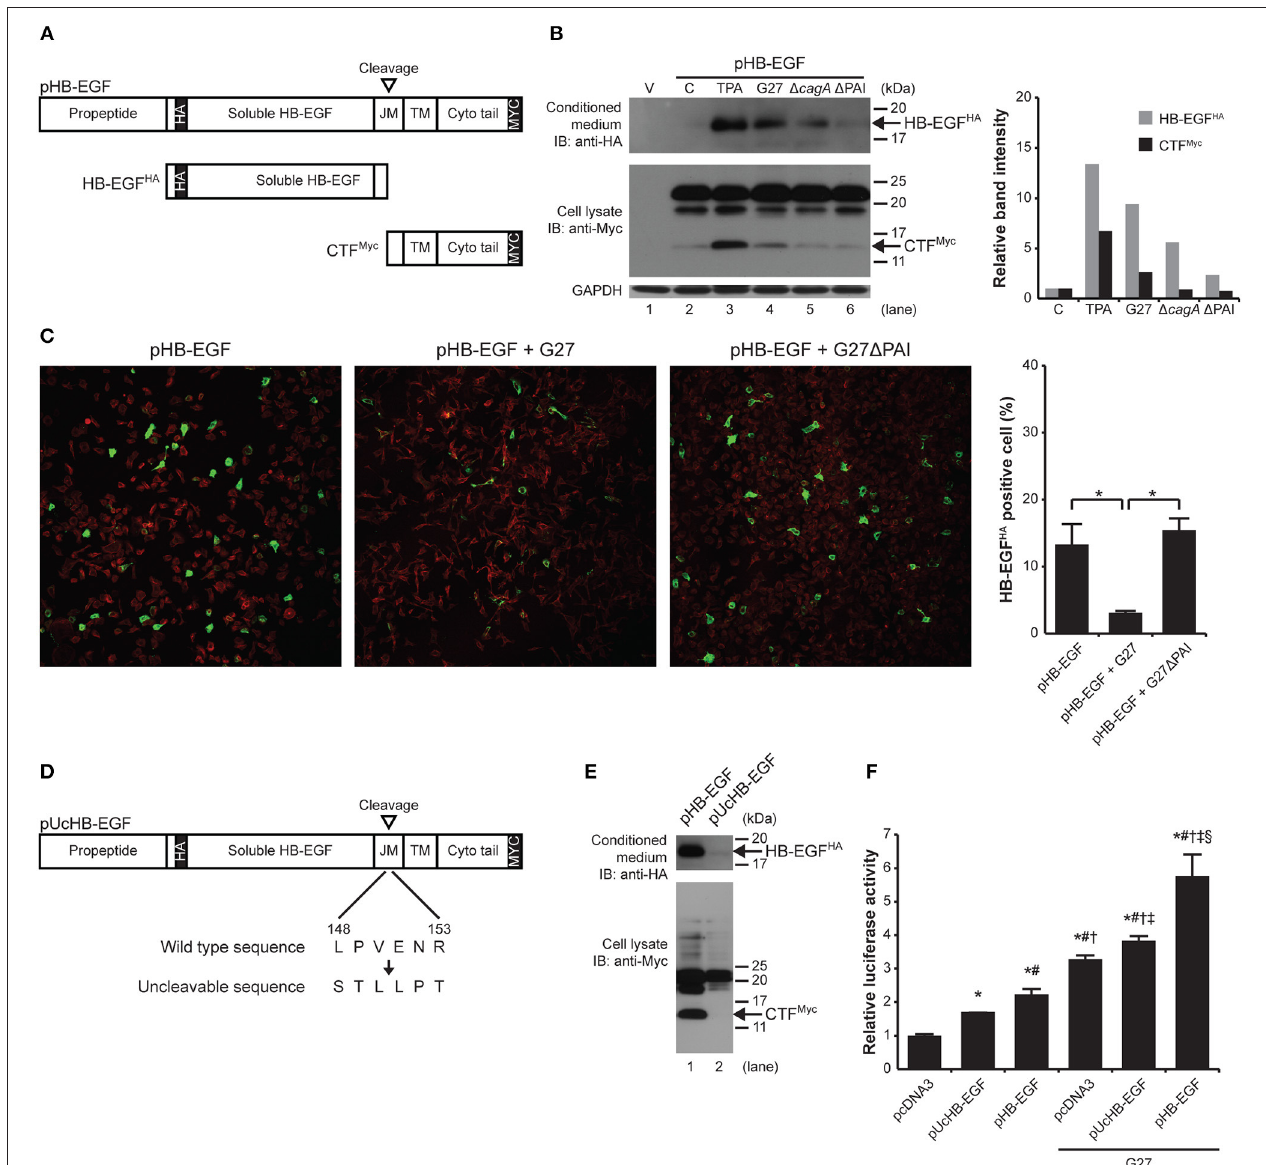
FIGURE 5 | H. pylori -induced HB-EGF shedding is important for gastrin expression. (A,D) Schematic diagrams of double epitope-tagged membrane-anchored proHBEGF-HA/Myc and Uncleavable proHBEGF-HA/Myc constructs, pHB-EGF, and pUcHB-EGF, respectively. (B) AGS cells were transfected with pcDNA3 (lane 1) or with pHB-EGF (lanes 2–6). Cells expressing proHBEGF-HA/Myc were treated with 1 µ M TPA for 30min, or infected with G27 WT, G27 1 cagA , or G27 1 PAI for 4h. Existence of shed HB-EGF HA in concentrated conditioned medium (upper panel) and CTF Myc in cell lysate (lower panel) were examined by Western blot with anti-HA and anti-Myc antibody, respectively. Intensities of each HB-EGF HA or CTF Myc band was measured and normalized to intensity of GAPDH. Intensities of each band were then compared to that of the control, and presented as relative band intensity. (C) AGS cells transfected with pHB-EGF were infected with G27 WT or G27 1 PAI for 4h and proHBEGF-HA/Myc was observed using confocal microscopy. proHBEGF-HA/Myc and actin were stained with green and red fluorescence, respectively. Each image is representative of three independent experiments. The proportion of HB-EGF HA positive cells was obtained by calculating ratio between the green-fluorescent area and the total fluorescent area. The average proportion of HB-EGF HA positive cells was derived from two independent experiments. (E) AGS cells were transfected with pHB-EGF (lane 1) or with pUcHB-EGF (lane 2), and treated with 1 µ M TPA for 30min. Concentrated conditioned medium (upper panel) and cell lysate (lower panel) were analyzed by Western blot to detect HB-EGF HA and CTF Myc , respectively. (F) G240-Luc cells were transfected with pcDNA3, pUcHB-EGF, or pHB-EGF, and subsequently infected with G27 for 4h. Gastrin promoter activity was measured by luciferase assay. *, #, †, ‡, and § indicates statistically significant difference ( P < 0.05) compared to pcDNA3, pUcHB-EGF, pHB-EGF, pcDNA3 + G27, and pUcHB-EGF + G27, respectively. Luciferase activity was presented as a relative ratio to that of pcDNA3-transfected, uninfected control cells. The mean values ± SD of three separate experiments performed in triplicate are